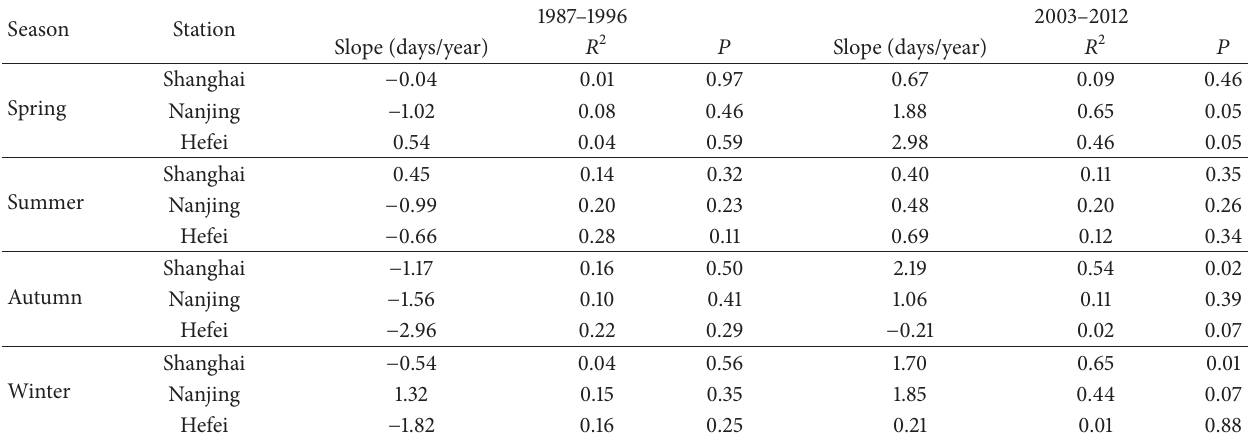
Table 4: Parameters of regression for phenological